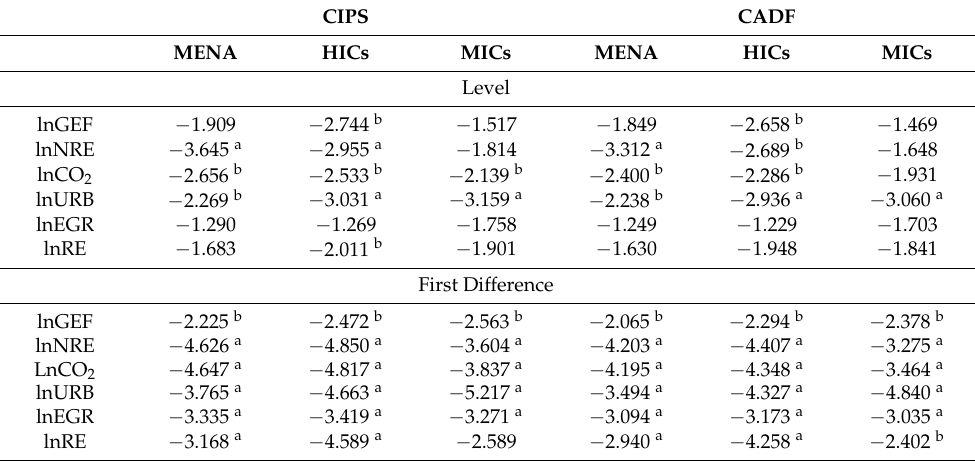
Table 7. Panel Unit Roots Results.